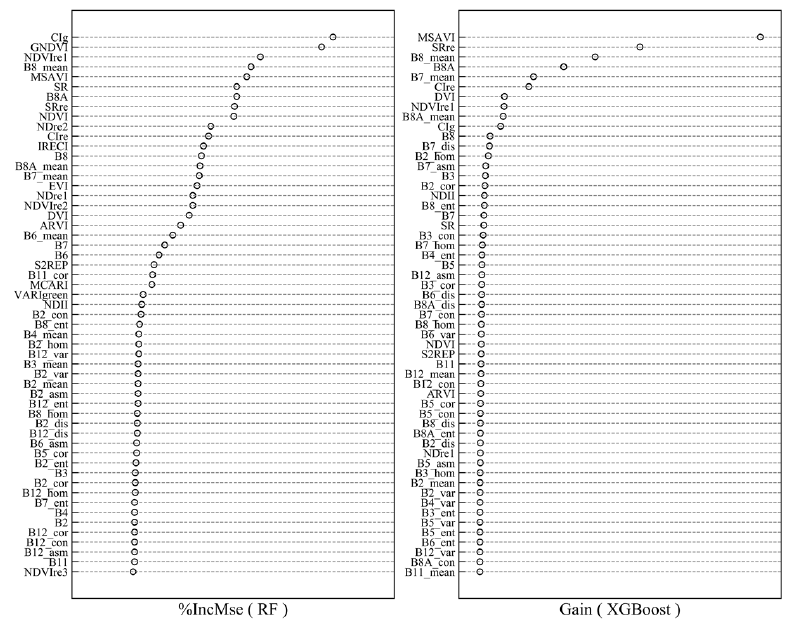
Figure 4. The first half of variable importance ranking for estimating AGB using the RF and XGB models in this study.